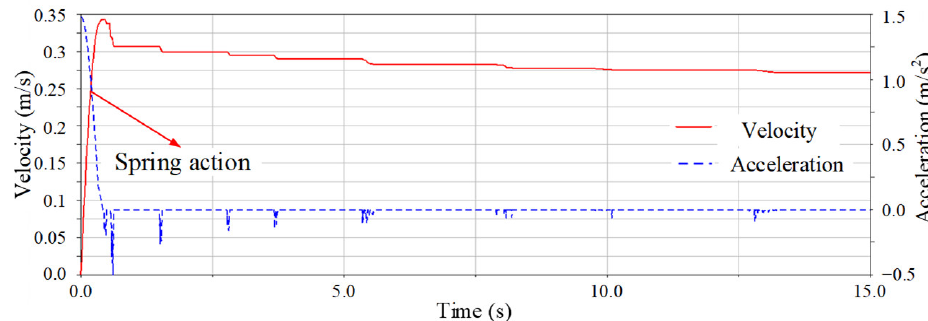
Figure 13. Variations of velocity and acceleration versus time.